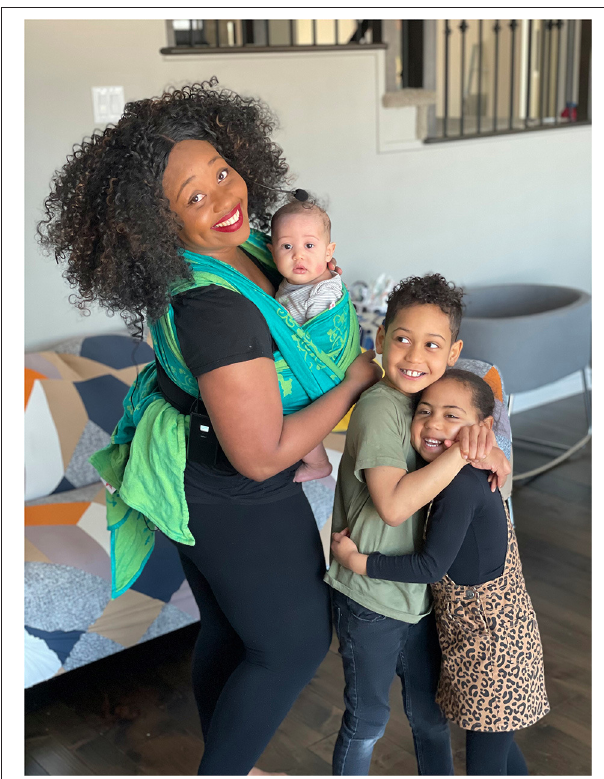
FIGURE 1 | Bernadette Betchi recently joined in the Black Class Action Lawsuit in the Federal Court of Canada. She is employed by the Canadian Human Rights Commission. Her career with the Public Service began at the Canada Revenue Agency. “My experience working there was emotionally and physically draining. I moved from team to team, was bridged in as a term employee, while my white counterparts were all given permanent and higher positions right away.” She is seeking concrete, permanent solutions to undo the damage that has already been done, but looking ahead, for her children and their children, so they don’t ever have to go through what her family is going